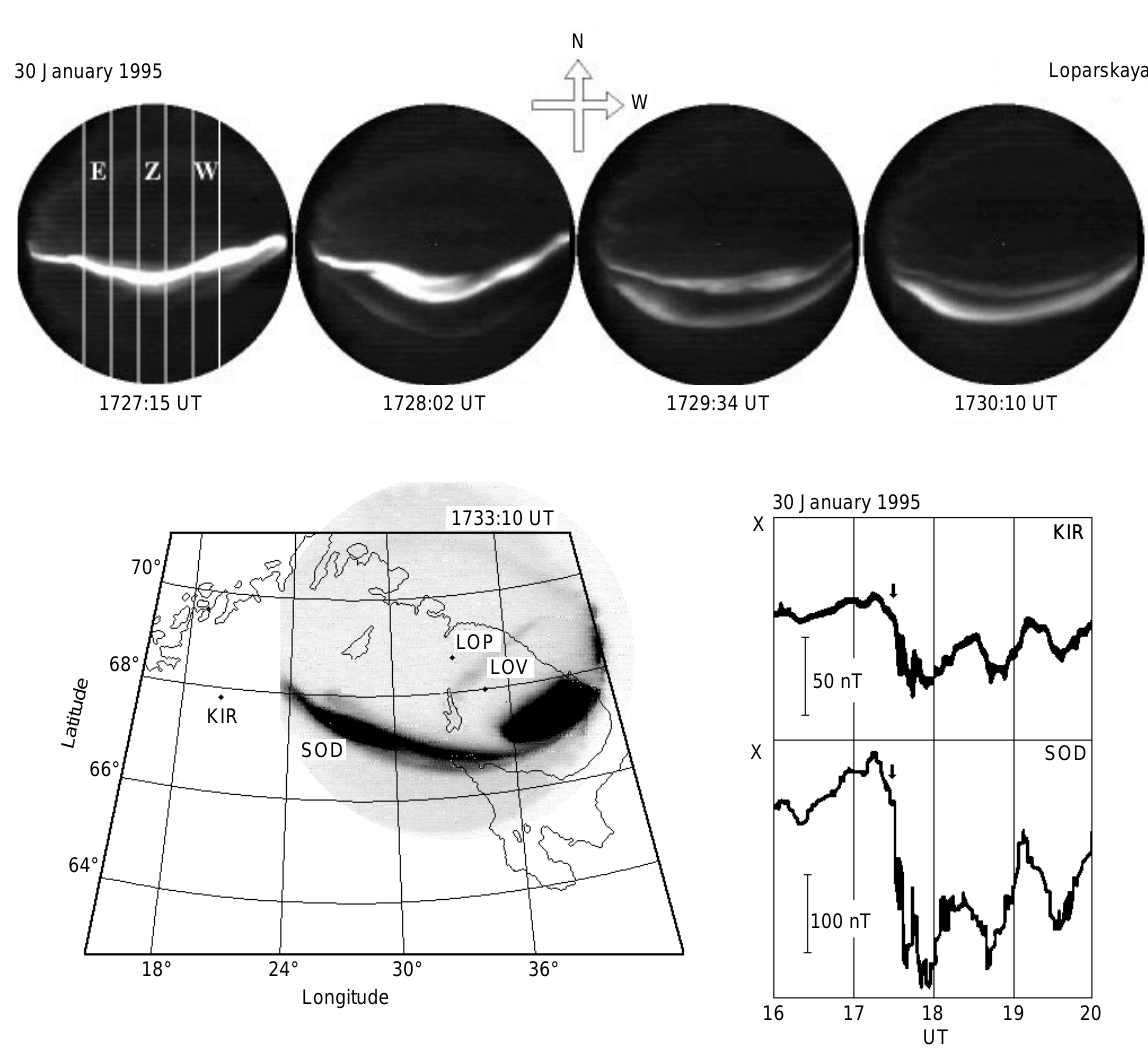
and Sodankyla ( bottom right ), black arrows show MAAS interval. The co-location of TV-camera (Loparskaya) and magnetometers (Lovo- zero, Kiruna and Sodankyla); TV-camera field of view is shown at the altitude of 110 km ( bottom